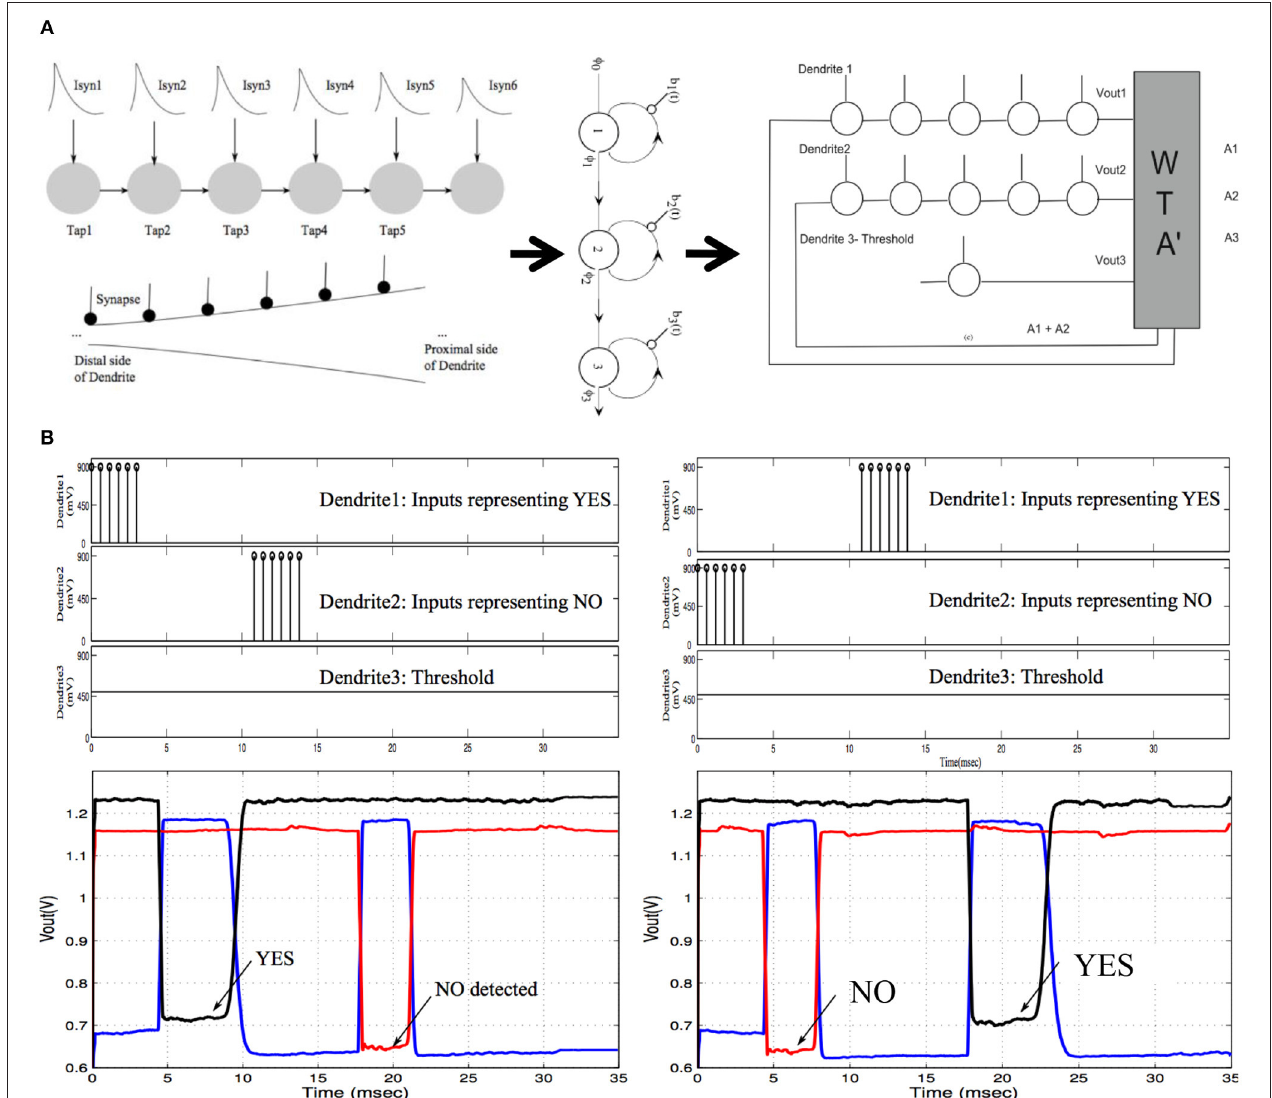
FIGURE 29 | Dendritic computation using the framework in Figure 28 . (A) Dendritic trees with increasing diameters have similar function to Hidden-Markov Model (HMM) trees used for acoustic classification. A YES-NO HMM classifier was built using dendritic lines to model linear HMM trees with a WTA terminating block. (B) Experimental demonstration of temporal classification using dendrite-enabled neurons to perform temporal classification (word spotting) similar to HMM classifier techniques. In the first case, YES is detected and then NO is detected, whereas in the second case, NO is detected and then YES is